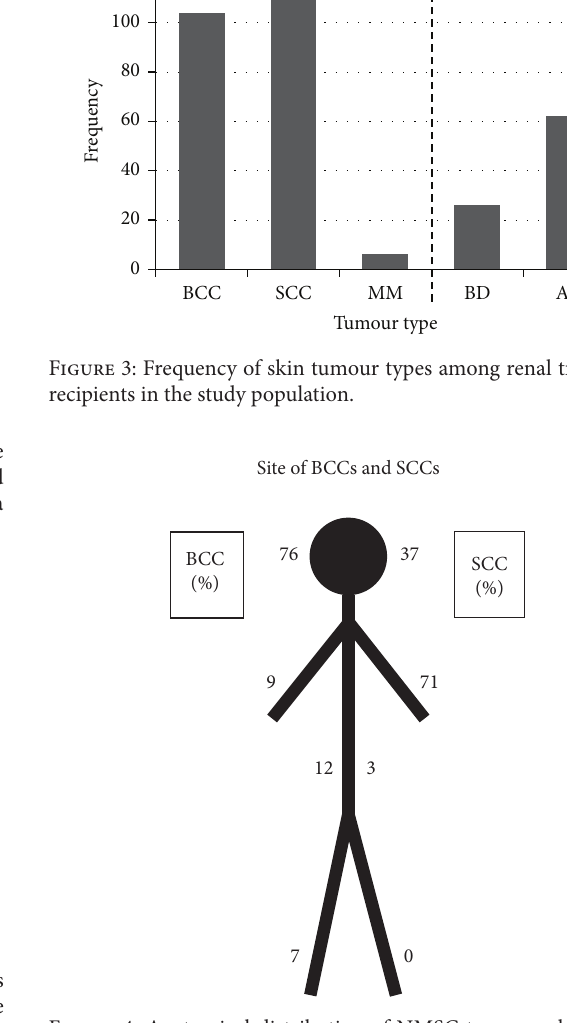
Figure 4: Anatomical distribution of NMSC tumours shows pre- dominance in sun-exposed